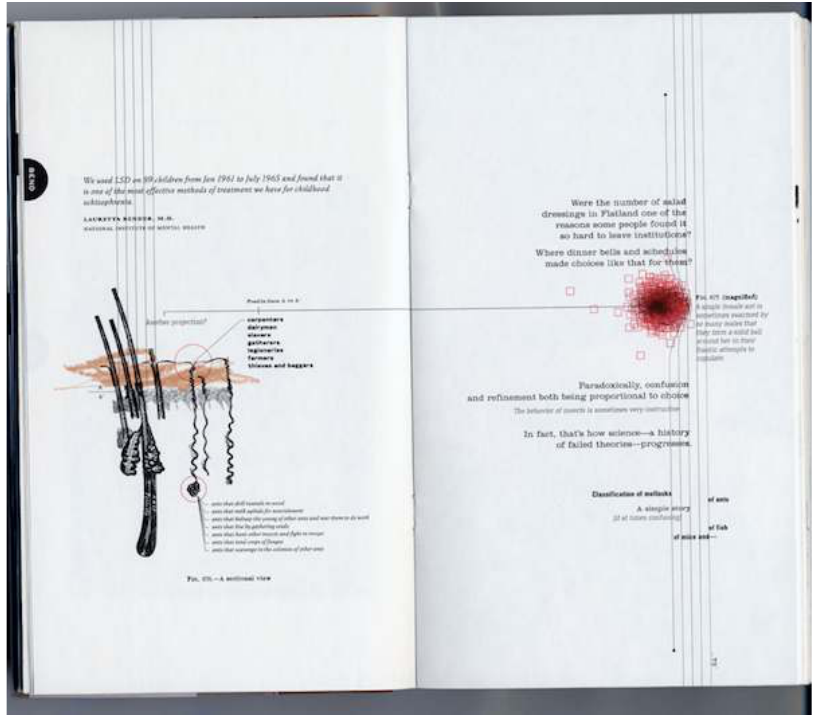
Figure 1. Extract from VAS: An Opera in Flatland , a novel by Steve